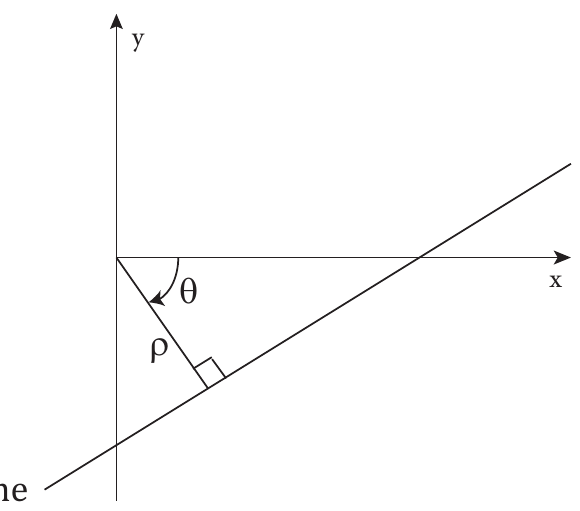
Figure 4. Parametric representation of a line. If θ angle is restricted to an interval of length π , the normal parameters for a line are unique. A point in the x – y plane corresponds to a sinusoidal curve in the ρ – θ plane, and collinear points in the x – y plane correspond to curves intersecting at the same point in the ρ – θ plane. Such points are called peaks.